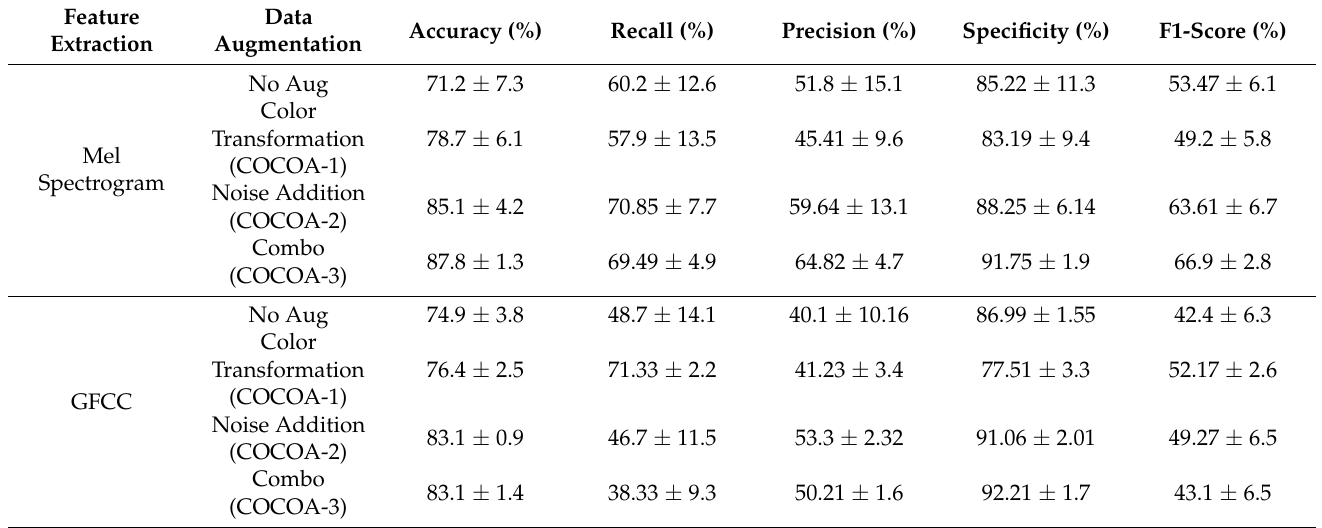
Table 7. Results Analysis of Positive COVID-19 vs. Healthy on applied feature extraction